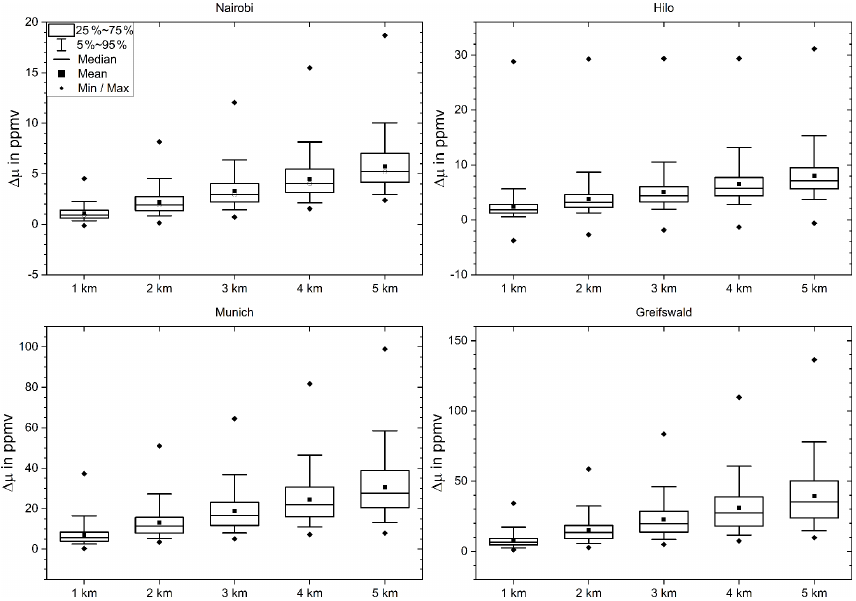
Figure 8. The effect of the vertical resolution and the related displacement of the cold point tropopause altitude on the water vapor saturation mixing ratio for four geolocations as a function of the vertical resolution for Gaussian kernels. For details, see Fig. 3.